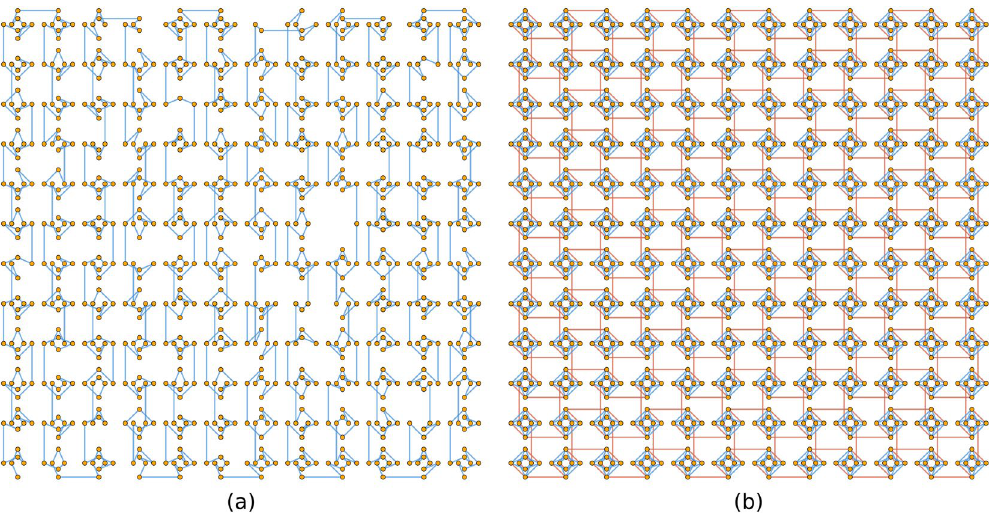
Figure 3. The embeddings associated with the ( a ) 1D and ( b ) 2D inverse problems are shown. The 1D embedding is obtained by removing vertices and edges from the physical hardware graph in Fig. 2a. The 2D embedding is obtained by contracting edges (in particular, the red edges) and removing edges from the Chimera graph in Fig.